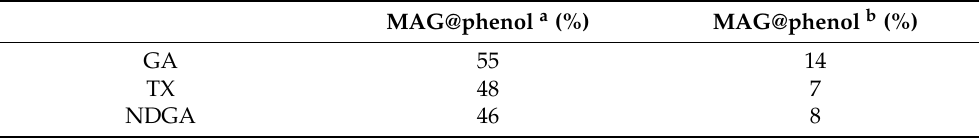
Table 1. Mass percentage of organic coating before and after the washing phase with acetonitrile.